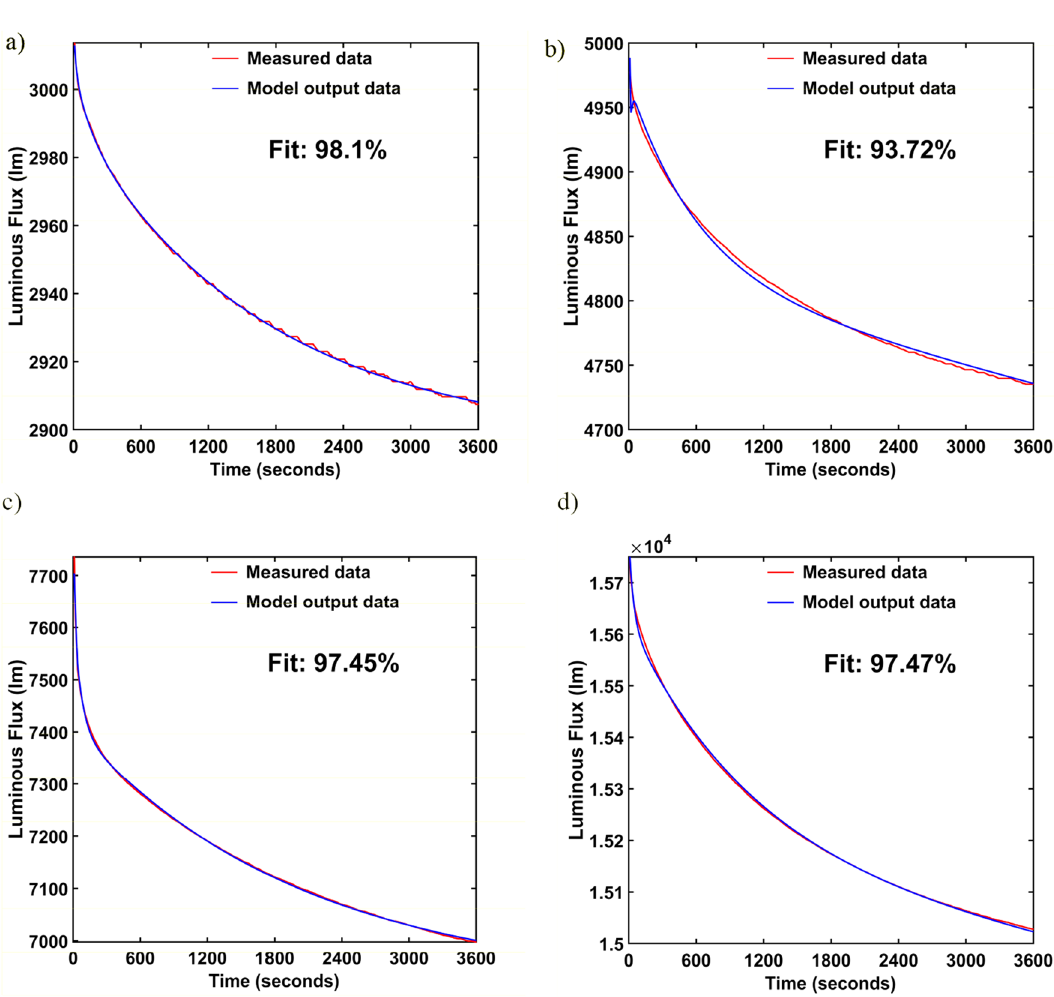
Figure 4. Identification of ( a ) L1 lumianire, ( b ) L2 luminaire, ( c ) L3 luminaire, ( d ) L4